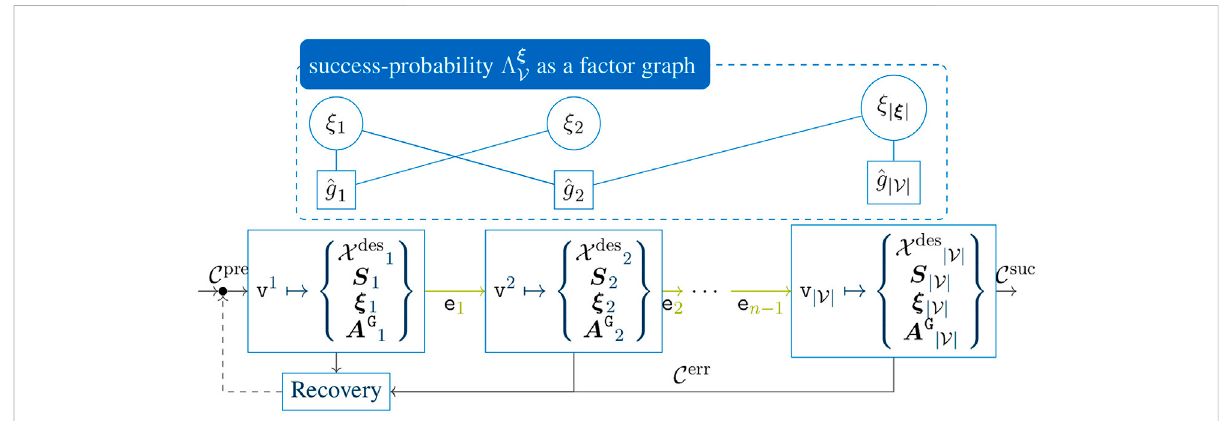
FIGURE 3 Graphical skill-formalism with an additional factor graph representation for the task success probability. The individual node parameters ξ v denote the meta parameters for each node, whereas X des v denote the set-values and S v denotes the selection matrices S frc R and S vel R for the controller from Figure 2. The factor graph denotesthe overalltask completion probability, while theadjacency matrix A G i for each vertex de fi nes the active sub-graph for each vertex, which de fi ne the success probability for the current node Γ ξ robot to the initial robot state whenever an error occurs in order to initiate a new